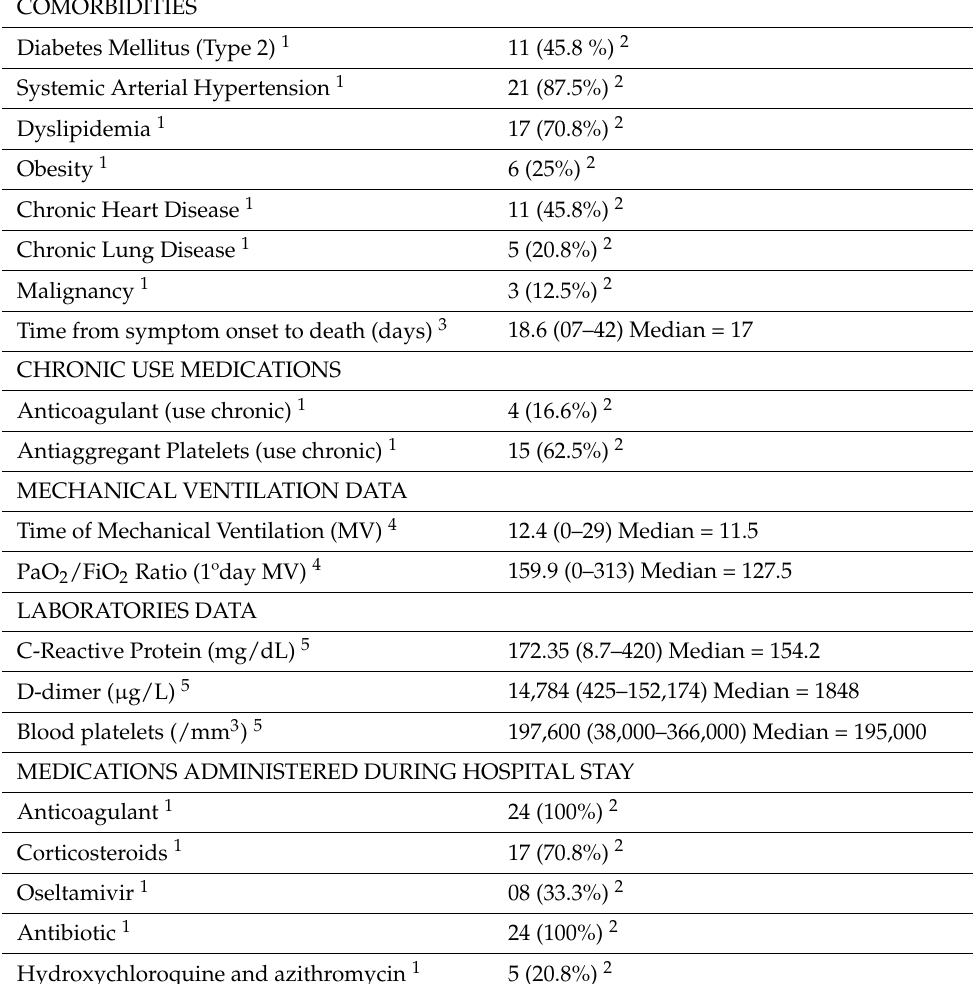
Table 2. Clinical data of the COVID-19